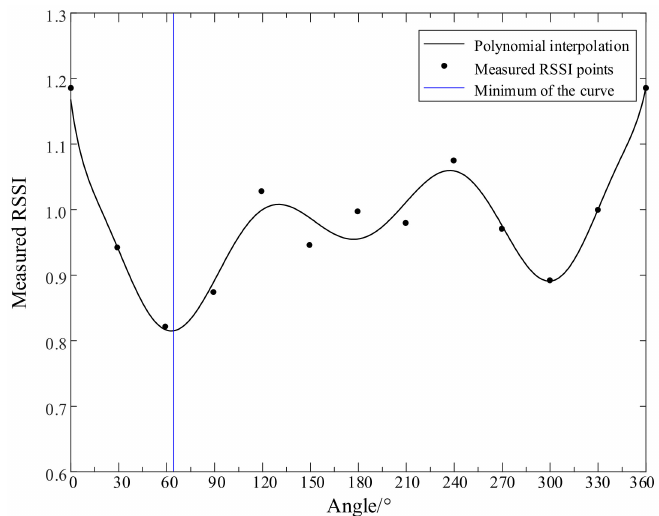
Figure 12. Diagram of polynomial interpolation.